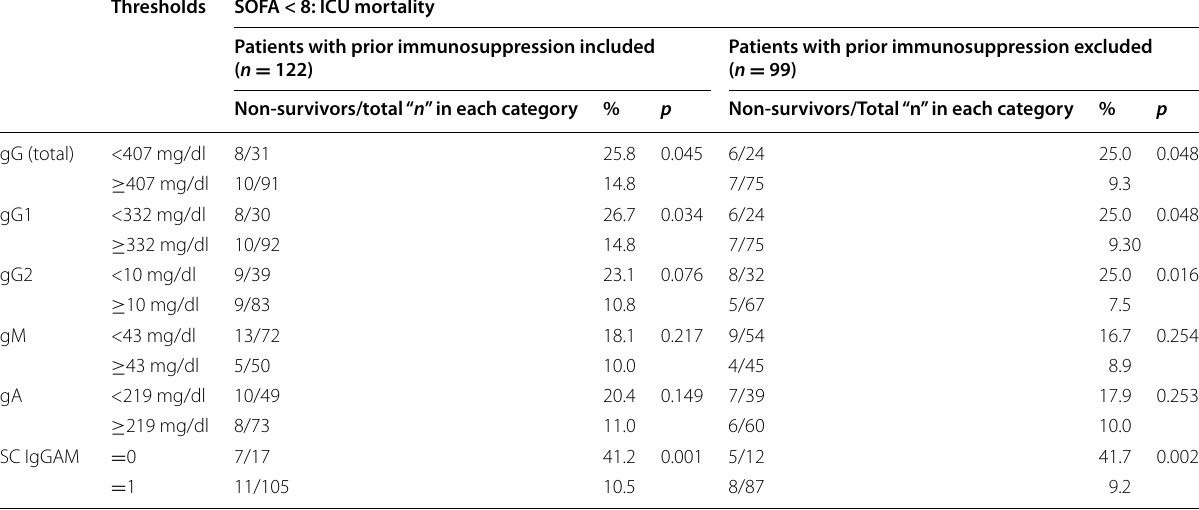
Table 2 Proportion of survivors and non-survivors at the ICU in the group of patients with SOFA score <8 depending on the immunoglobulin thresholds